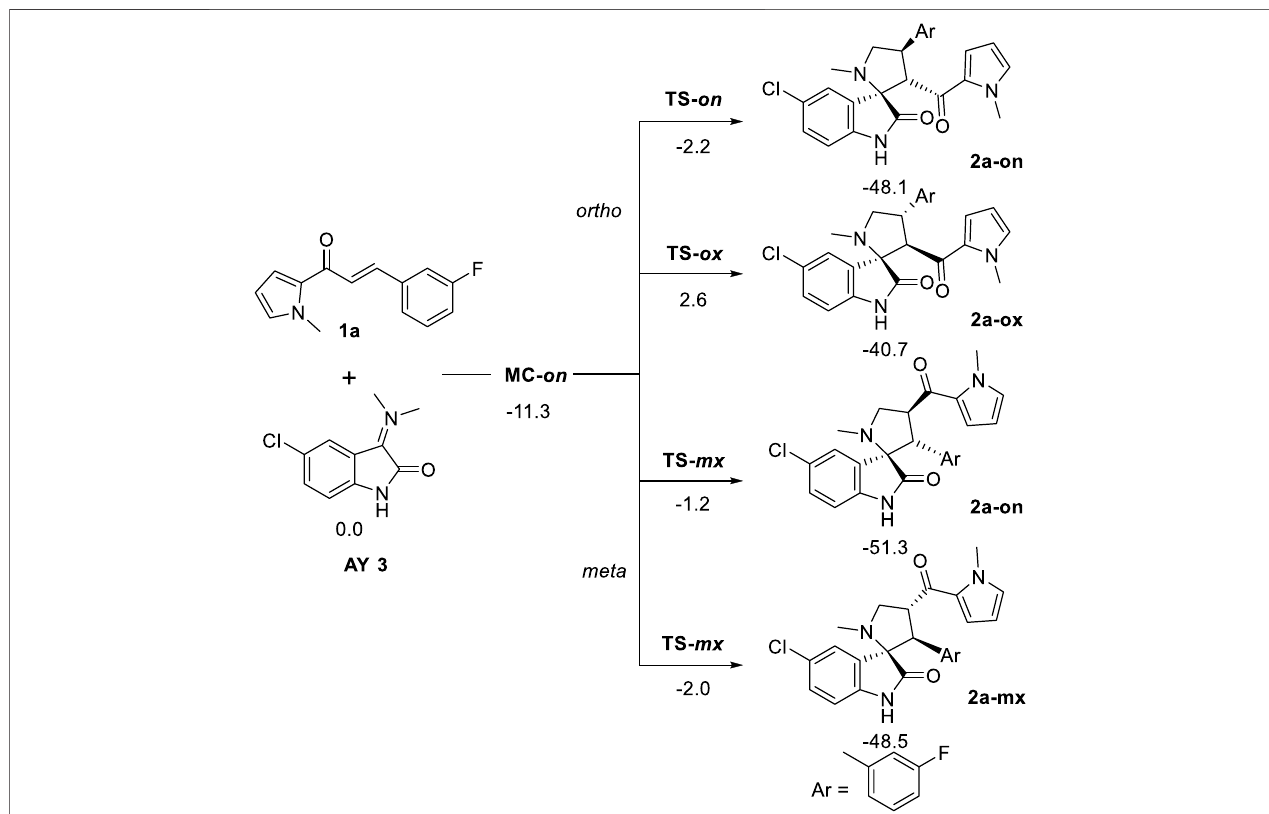
SCHEME4| 32CA reactionofAY 3 withtheethylenederivative 1a . ω B97X-D/6-311G(d,p)relativeenergiesinmethanol,withrespecttoseparatedreagents,aregiveninkcal · mol − 1